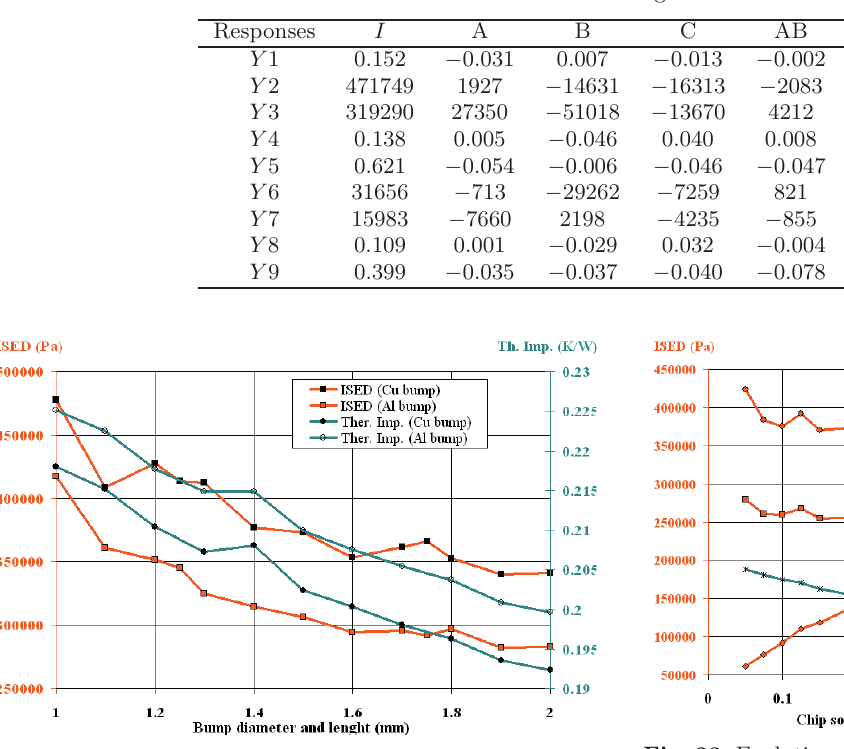
Table 7. DoE effects and significance test results.